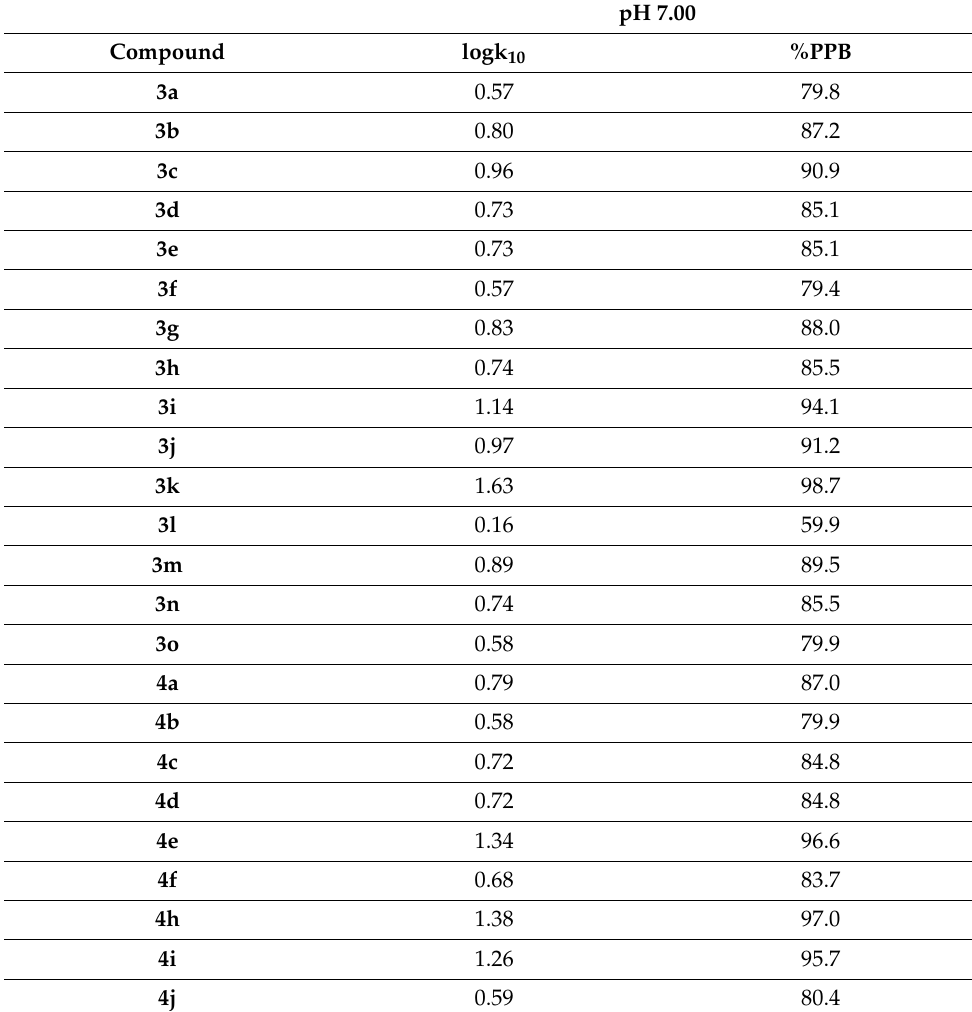
Table 7. HSA retention factors and estimated plasma protein binding (% PPB) of the investigated coumarin